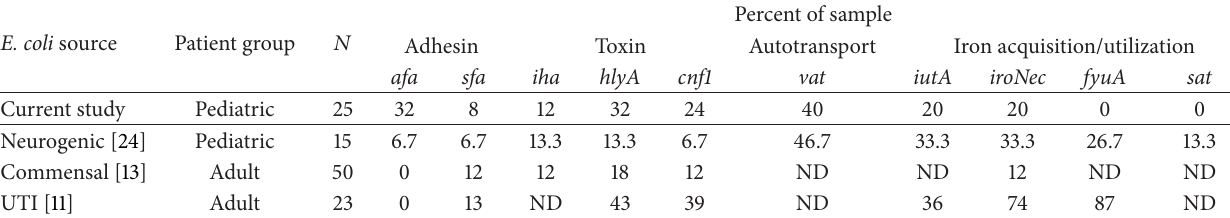
Table 3: Virulence factor genes of E. coli